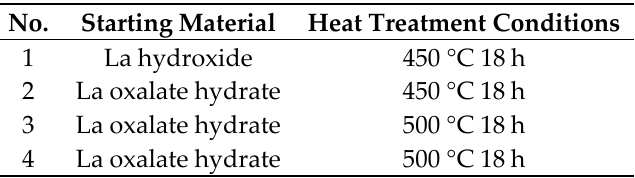
Table 1. The conditions of heat